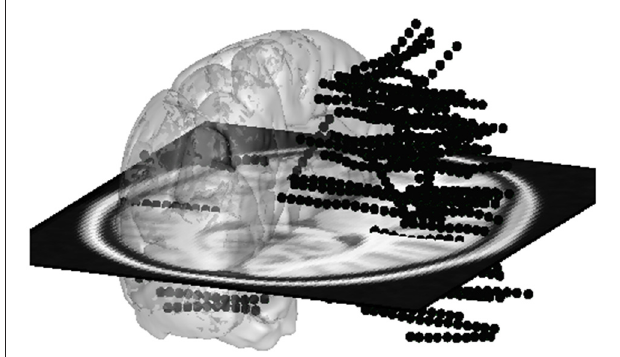
FIGURE 10 | All electrode contacts from four patients superimposed on a glass template brain. If lateralization is not important for the current study, all contacts from the left side can be switched to the right side to combine left and right